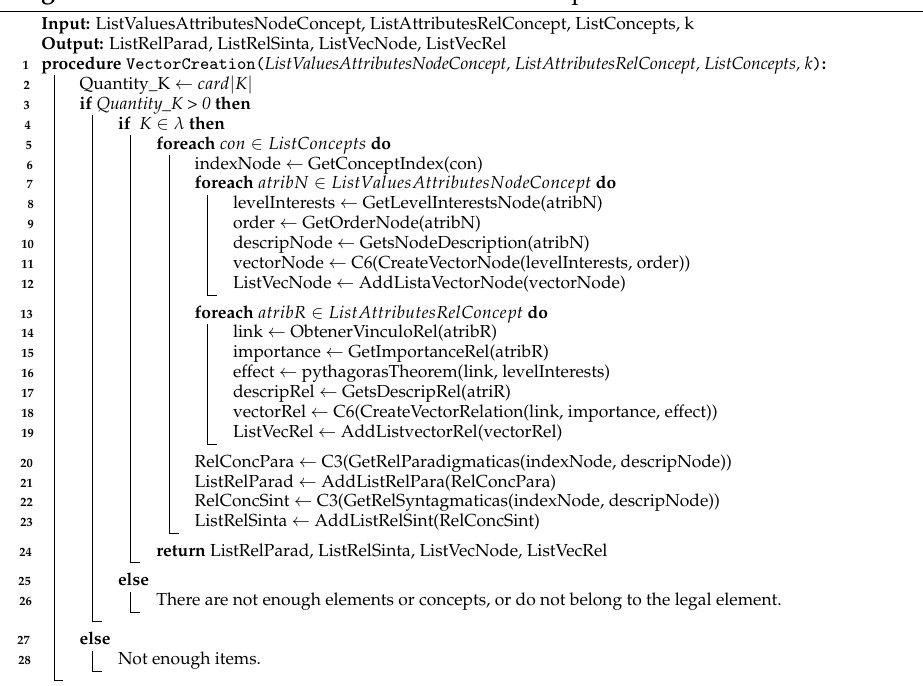
Algorithm 1: Creation of vectors and related concepts in